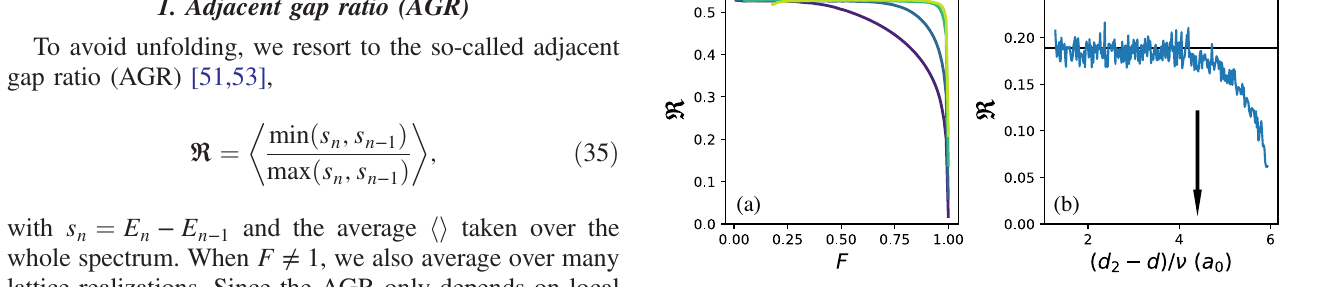
FIG. 11. (a) Average AGR of 2000 realizations of a lattice of scatterers as a function of F for d ¼ 5 , 10, 30, and 70 in sequence from dark to lighter line color, ν ¼ 30 . (b) AGR for a filled lattice as a function of ð d 2 − d Þ = ν with d 2 from d in Table I for D ¼ 2 . D l; m Þ from Eq. (34) with m ¼ l ¼ ν − 1 , The arrow marks d c ð while the horizontal line shows the RMT prediction for AGR incorporating the appropriate symmetries of the scatterers on the lattice; see text. Note that in both plots increasing values of the abscissa mean higher density of